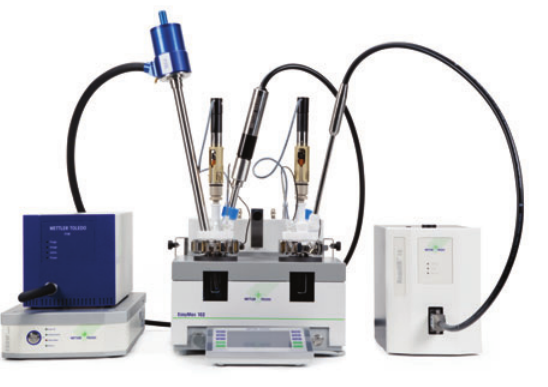
Figure 2 The complete solution for improved process